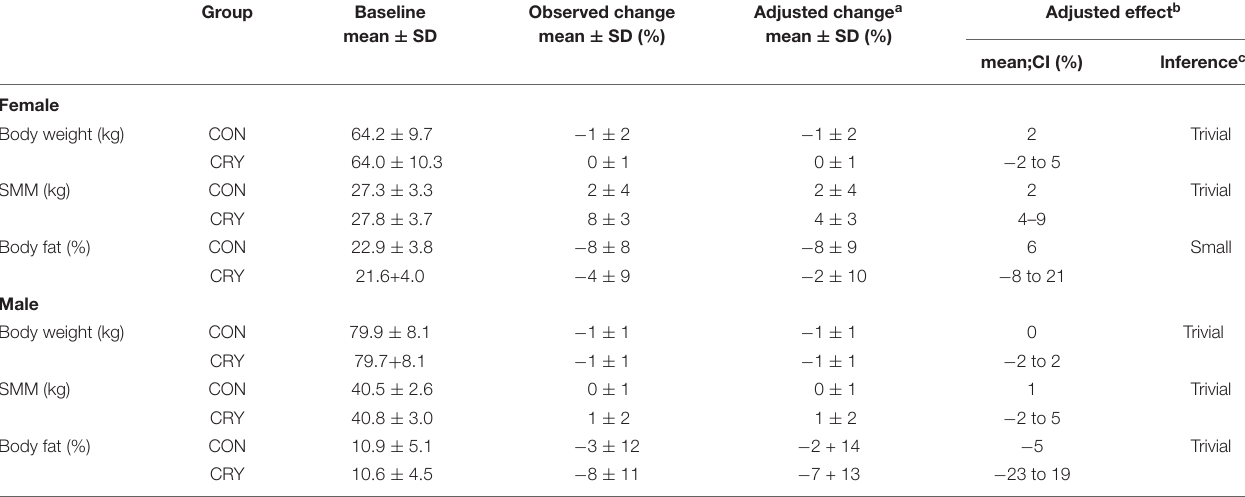
TABLE 2 | Participants’ body composition before and after the 2-week training program supported with the whole body cryostimulation protocol.